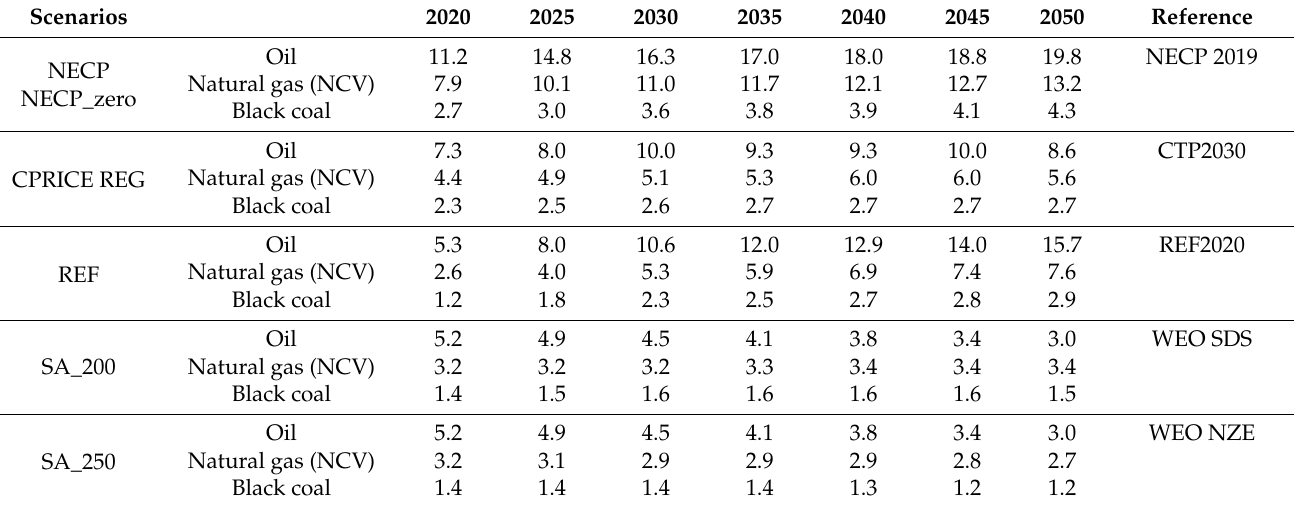
Table 5. Fossil fuel prices (EUR